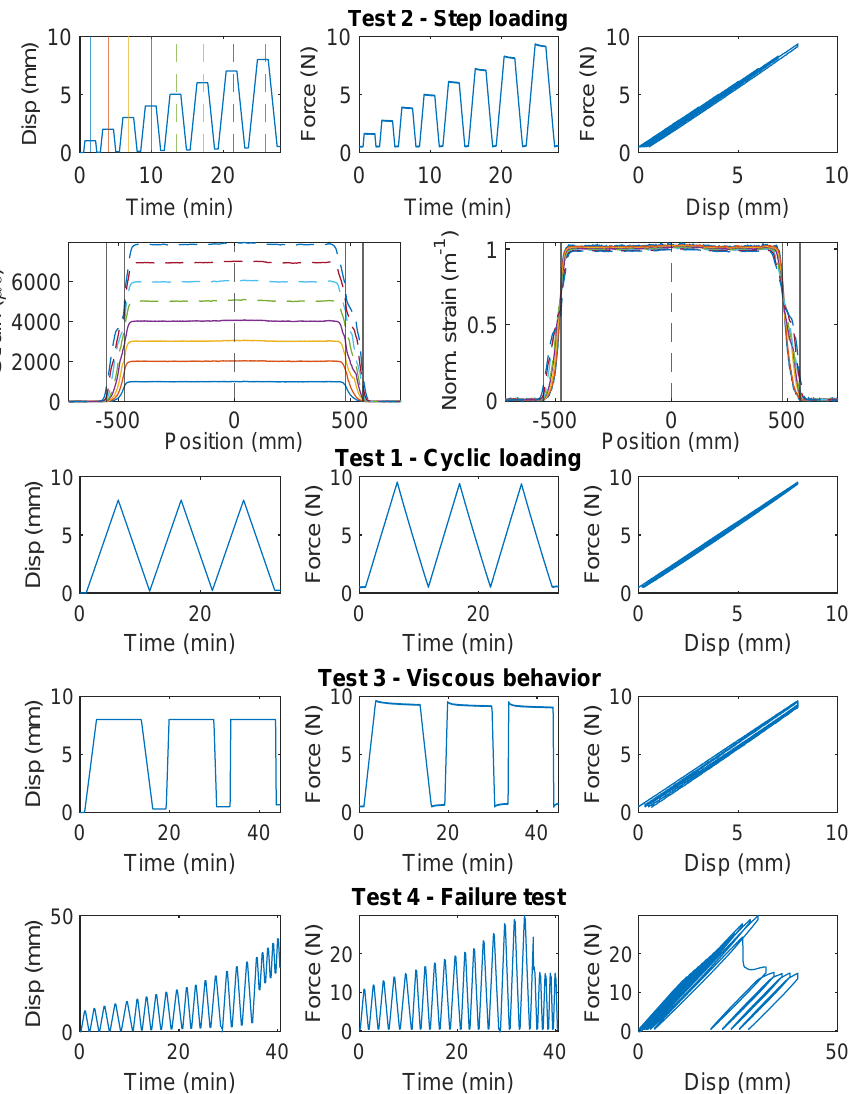
Figure 6. The loading protocol, force–displacement relation and strain distributions under increasing displacement levels (represented by different color lines) for Specimen 3 of the PUR-PAI 2.0 mm